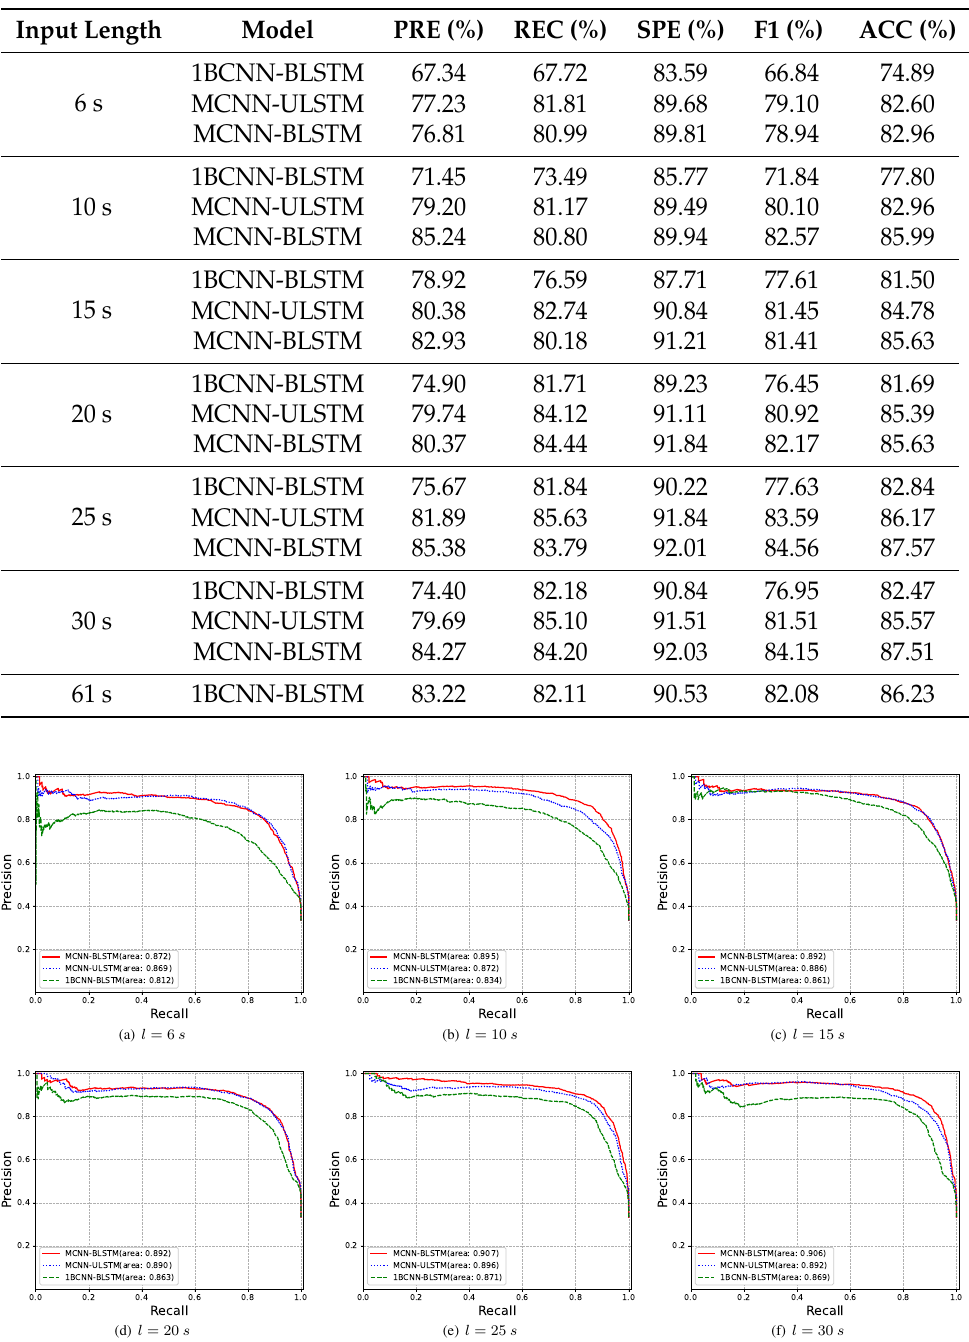
Table 4. Classification performance using MCNN-BLSTM on the PhysioNet/CinC Challenge 2017. Input Length